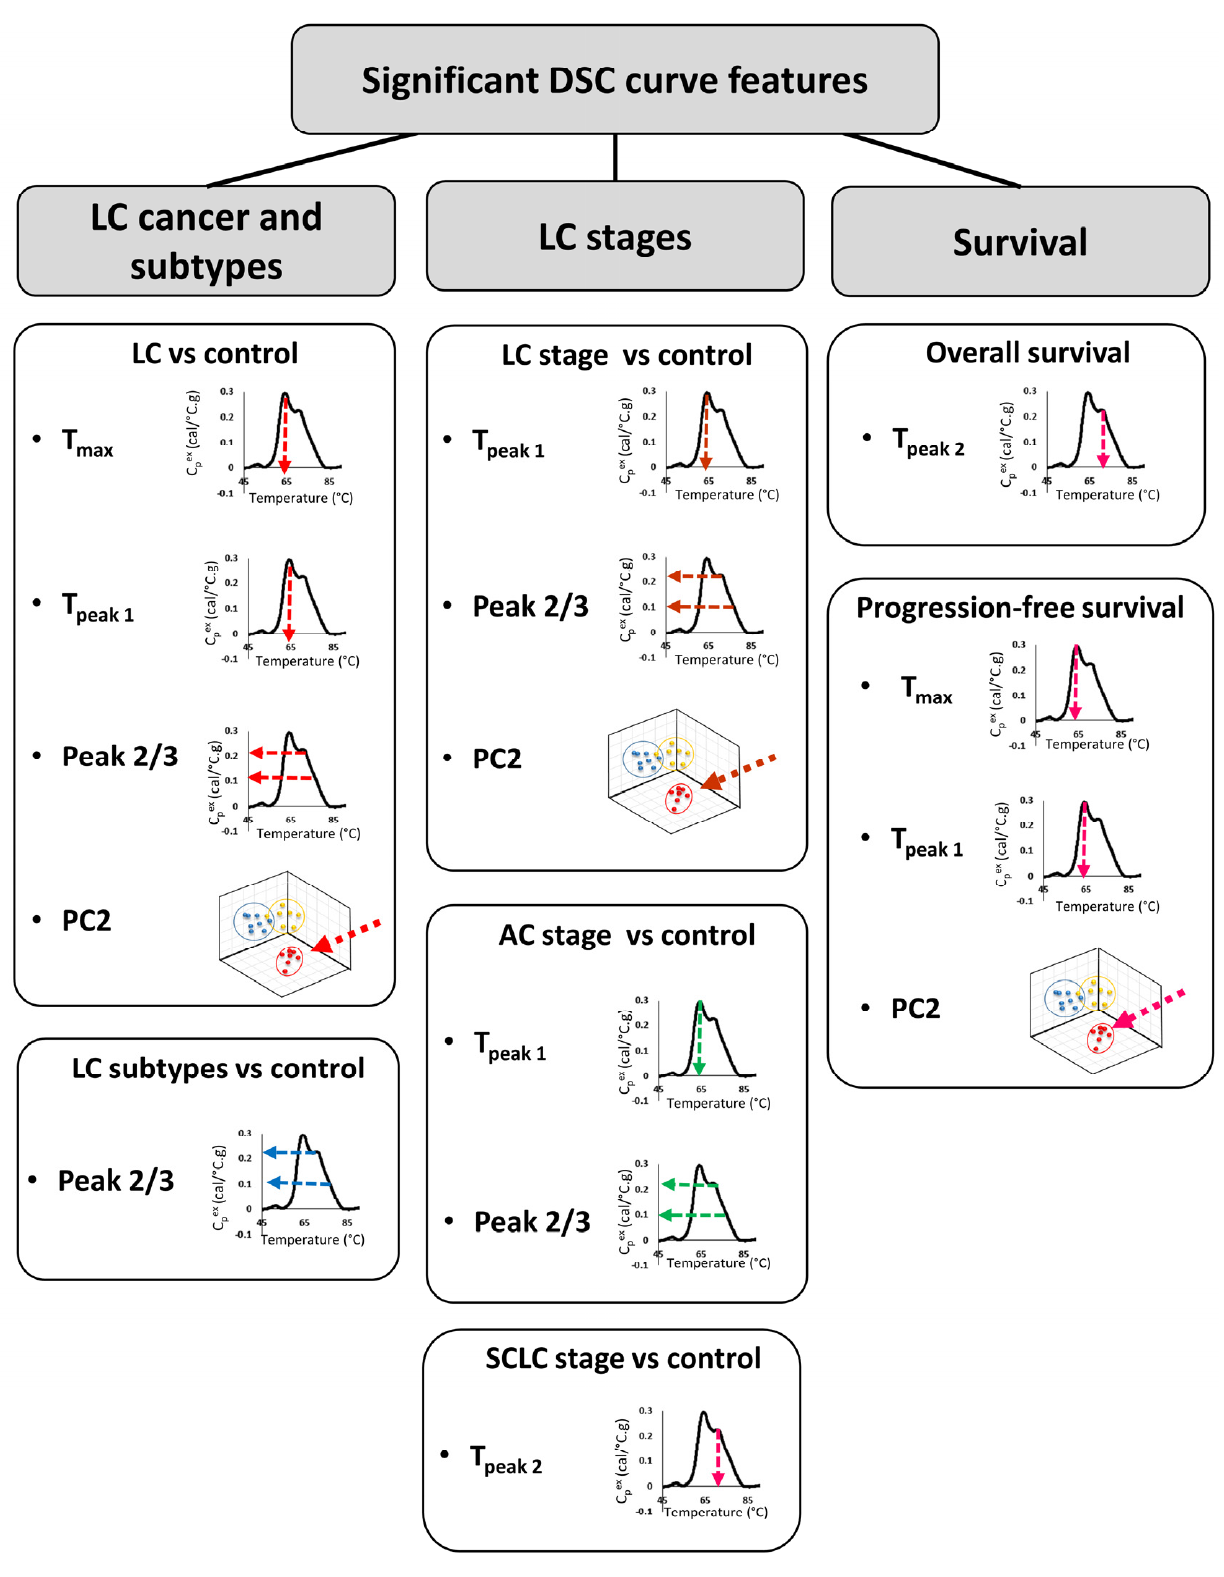
Figure 7. Summary of DSC curve features that were found to differentiate LC type, stage, and survival. In order to evaluate the use of DSC parameters as prognostic criteria, we compared OS and PFS of LC patients dichotomized based on the value of each summary metric or PC. We found that only T peak 2 (median) was significantly associated with OS of SCLC